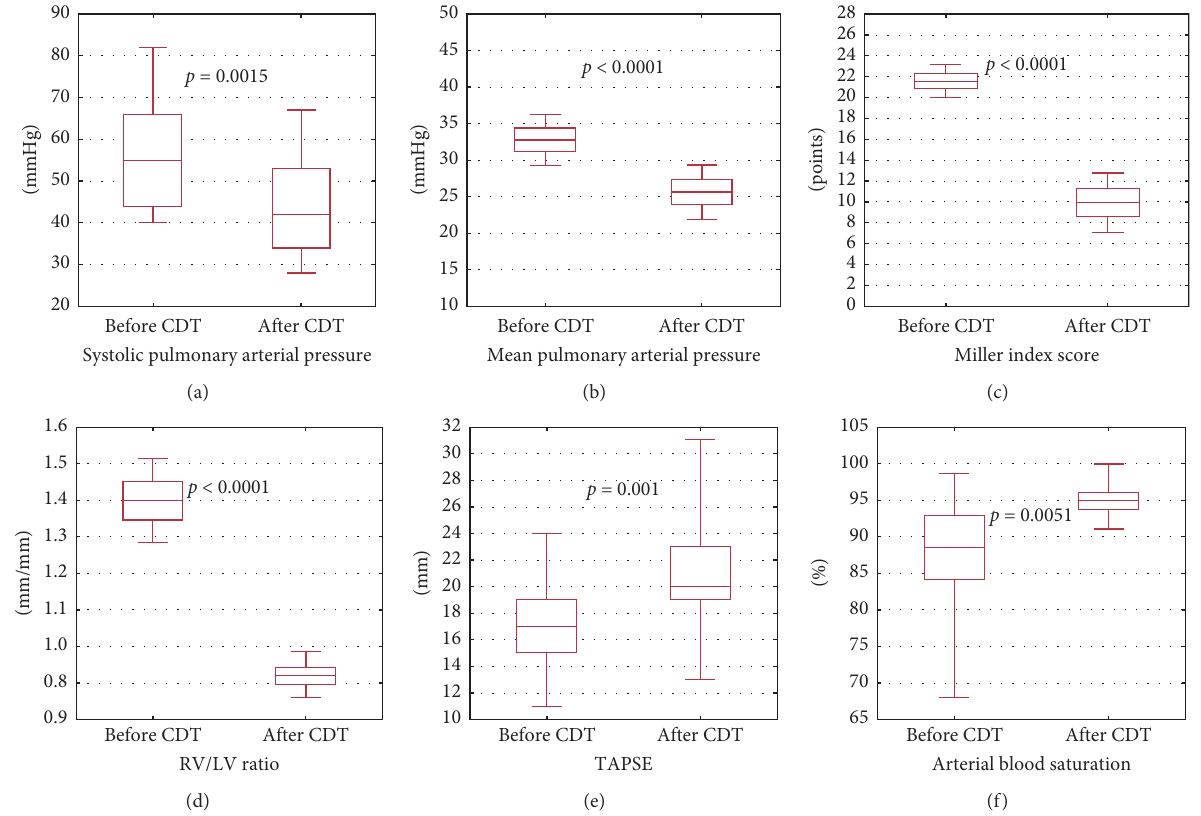
Figure 4: Hemodynamic and echocardiographic outcomes before and after CDT. CDT � catheter-directed mechanical aspiration thrombectomy, LV � left ventricle, RV � right ventricle, and TAPSE � tricuspid annular plane systolic excursion. (a) Change in systolic arterial pressure. (b) Change in mean pulmonary arterial pressure. (c) Change in Miller index score. (d) Change in right ventricular/left ventricular ratio. (e) Change in tricuspid annular plane systolic excursion. (f) Change in arterial blood